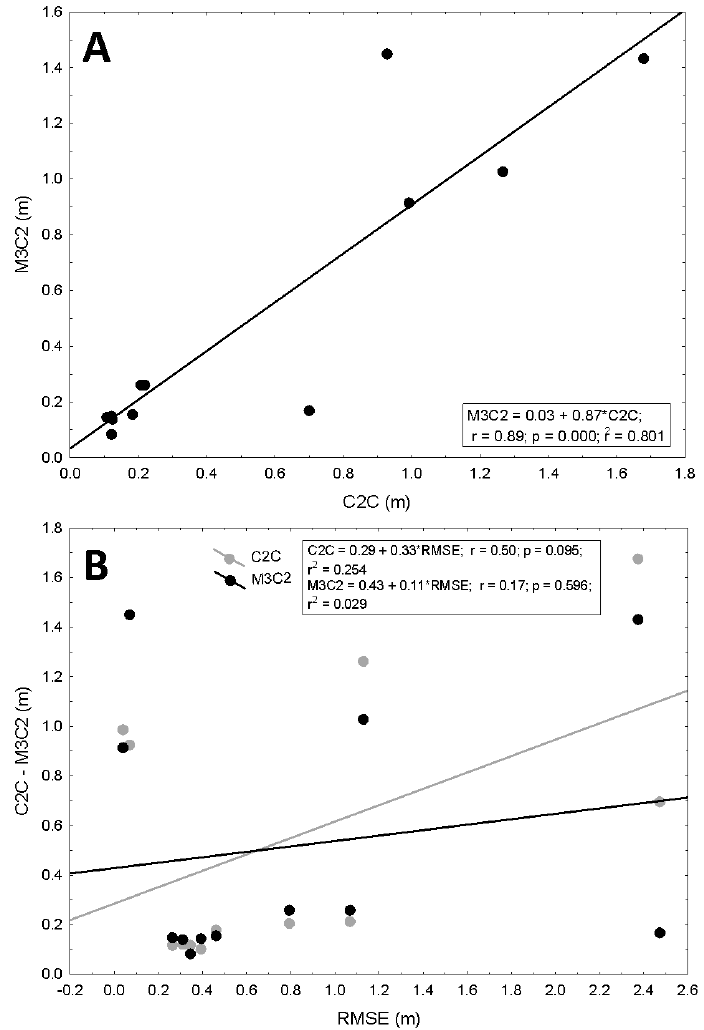
Figure 6. Correlation between the Cloud-to-Cloud (C2C) and the Multiscale Model-to-Model (M3C2) ( A ) and between the C2C and the M3C2 with the RMSE ( B